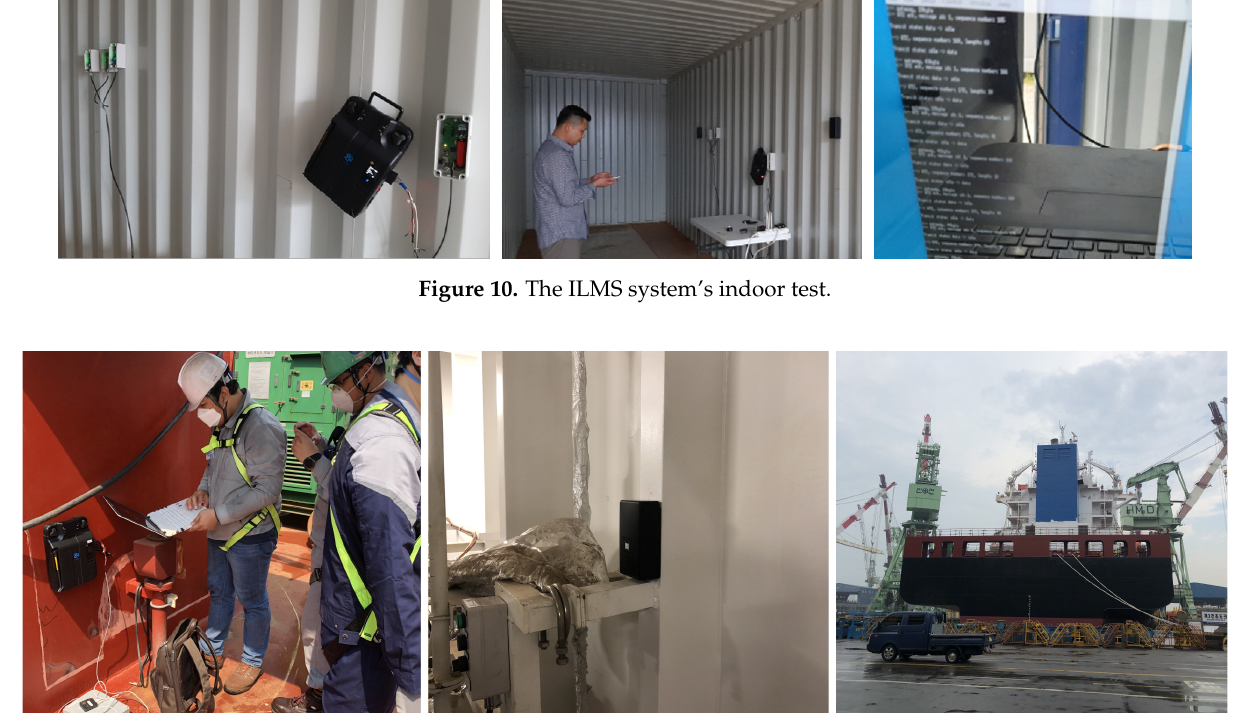
Figure 11. The ILMS system’s ship